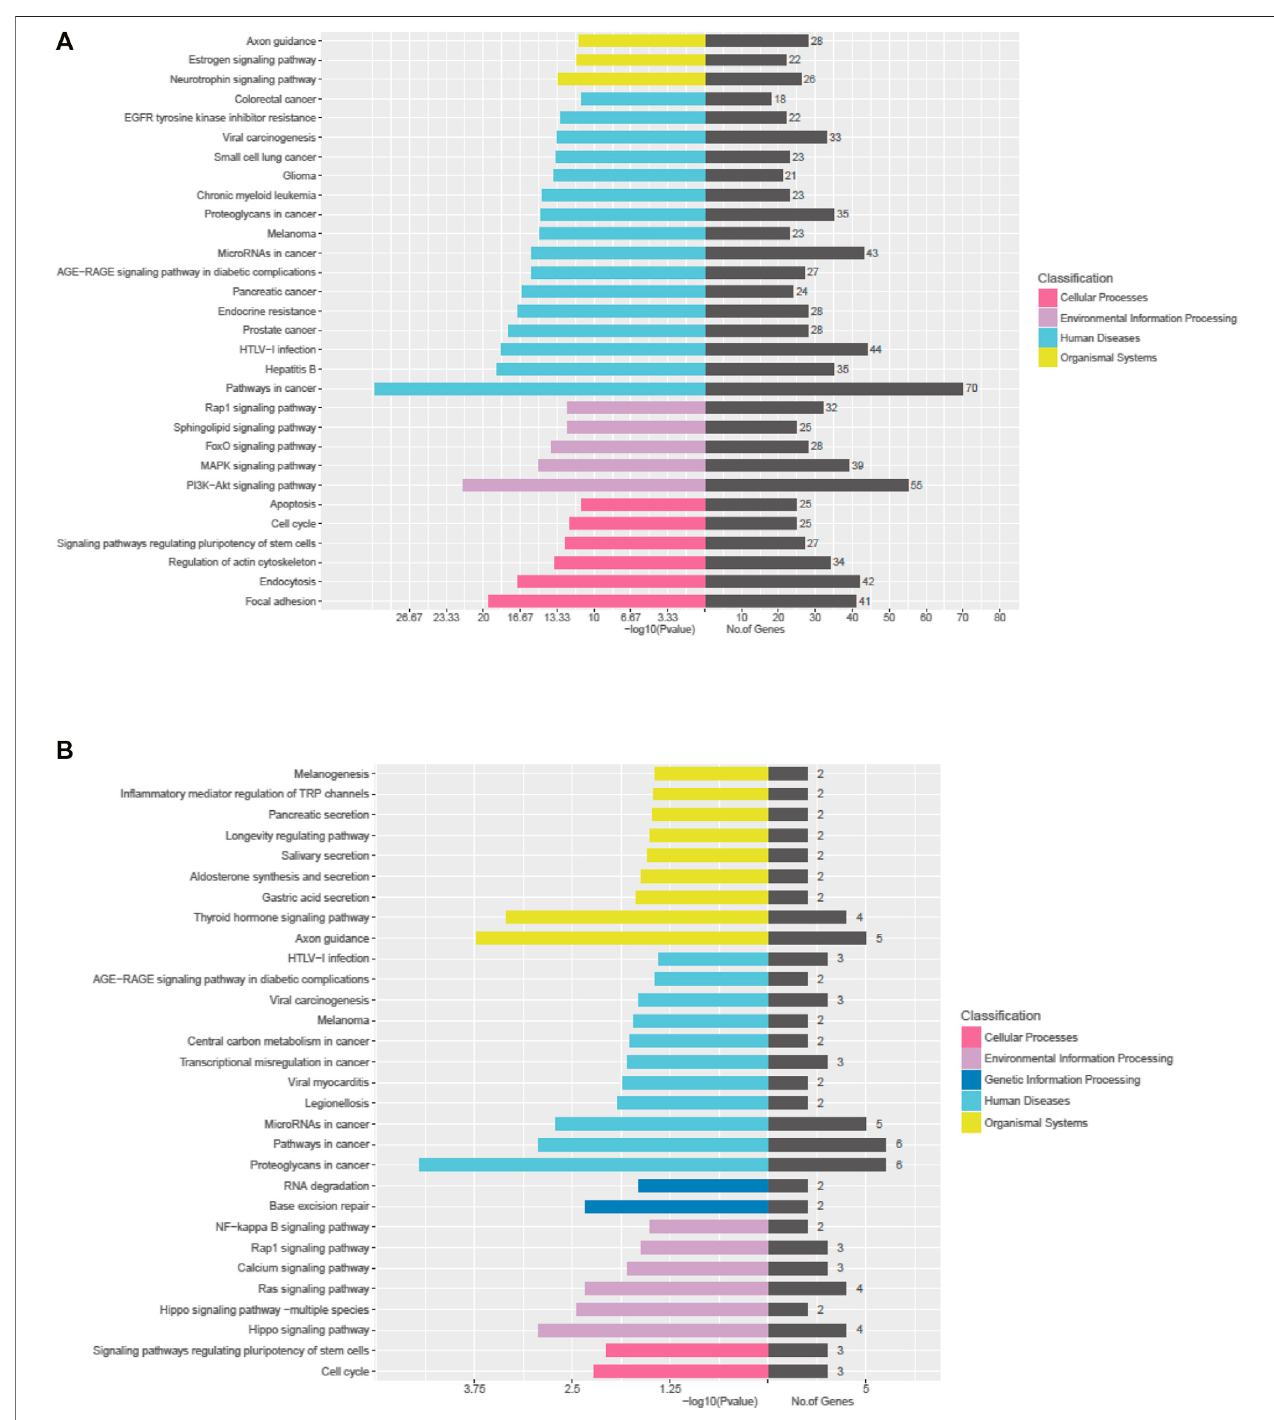
FIGURE 3 | KEGG pathway analyses of the dysregulated exosomal miRNAs. (A) KEGG pathway analysis of upregulated miRNAs. (B) KEGG pathway analysis of downregulated miRNAs.